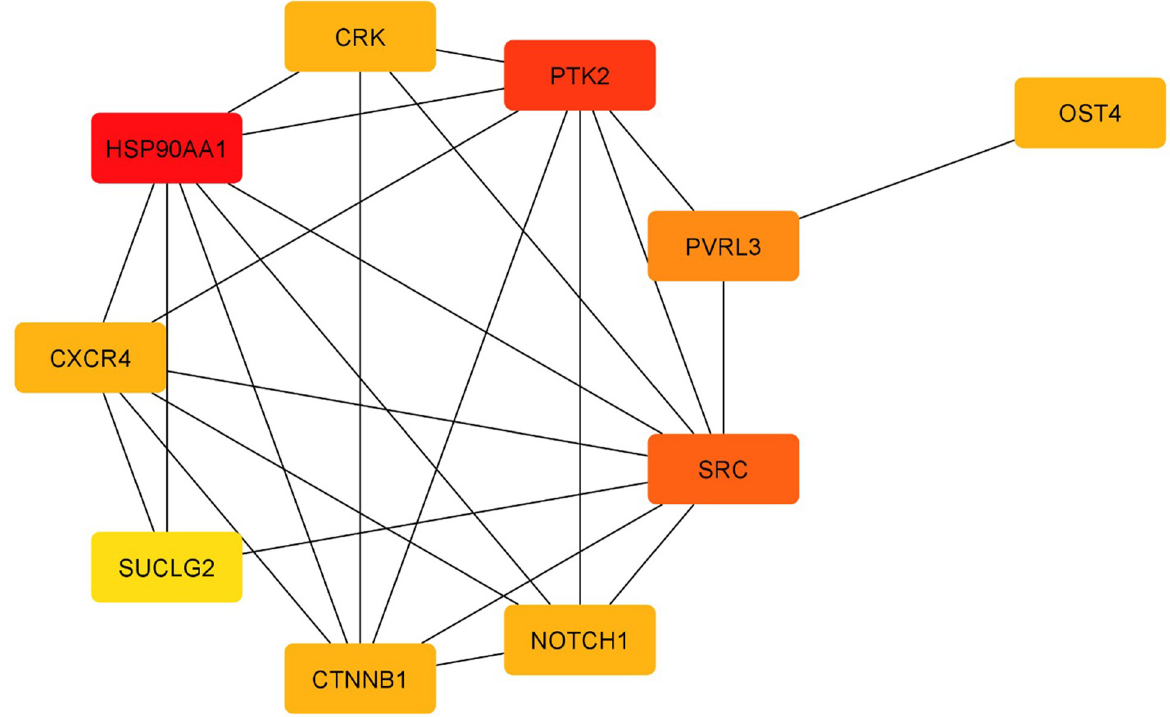
Fig 5. Bottleneck subnetwork constructed based on PGSA selected genes in breast cancer. Red and yellow colors indicate higher and lower bottleneck scores in the network, respectively.